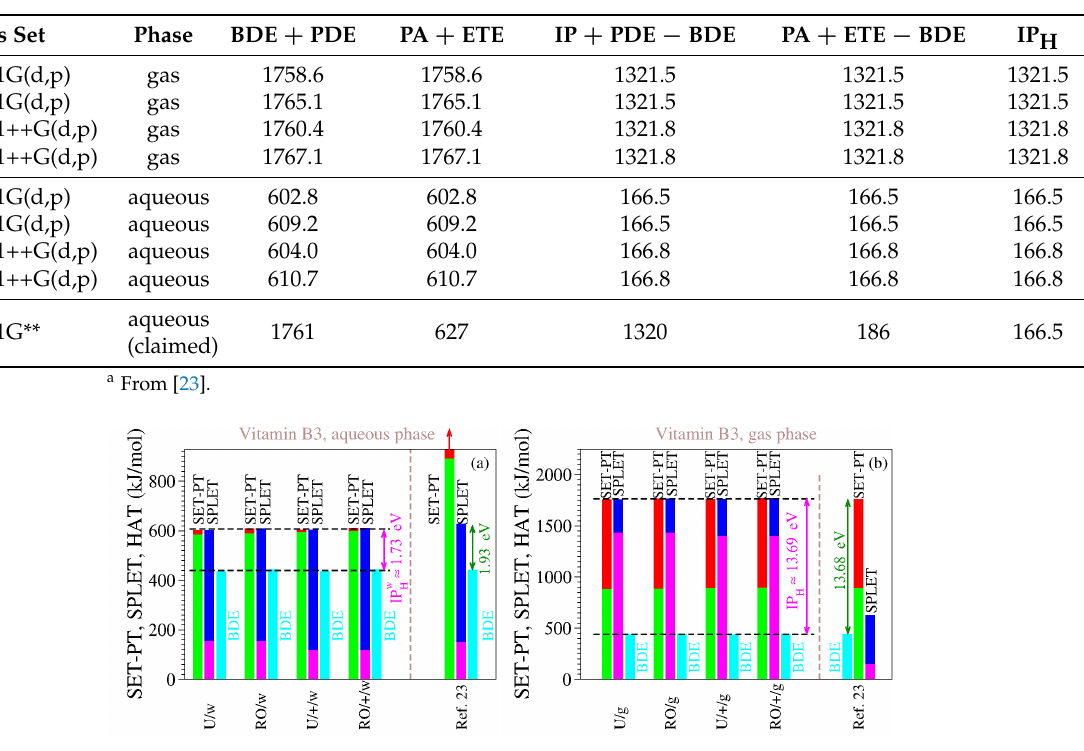
Table 10. Combined enthalpies of reaction (in kJ/mol) for the three antioxidant mechanisms (HAT, SET-PT, and SPLET) for vitamin B3 in the gas and aqueous phase along with those extracted from [23]. Notice that our estimates satisfy both Theorems 1 and 2 while those of [23] do not.